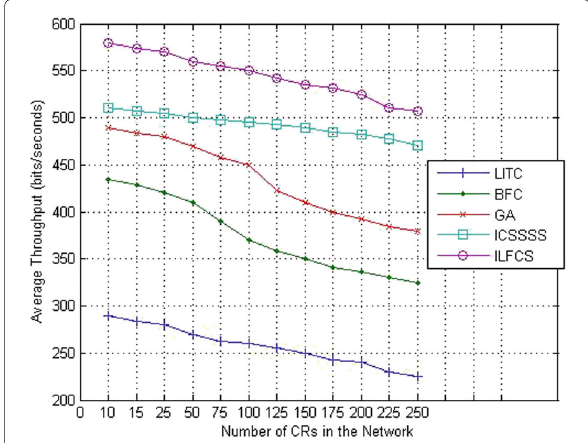
Fig. 8 Average throughput under different network densities. The results of diverse simulation experiments to measure the average throughput at different numbers of CR nodes for the BFC, LITC, GA, ICSSSS, and the ILFCS are illustrated